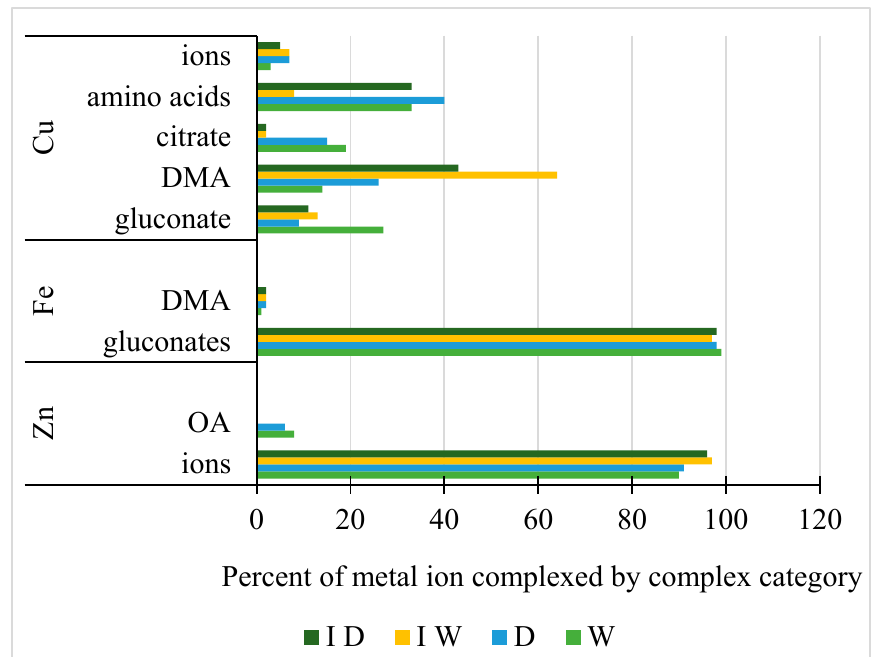
Figure 5. Predicted complexation as % of the total for three essential metals (Cu, Fe, and Zn) when present together in the rhizosphere for four growth conditions: non-inoculated watered (W), non-inoculated (D), inoculated with Pc O6 and watered (I W), and inoculated with Pc O6 with drought-stress (ID). For modeling pH 7.25 was used. Complexation with amino acids, inorganic anions and organic acids (OA) are shown, as well as chelation with the phytosiderophore, DMA, and the presence of free ions. The full data set is provided in Supplementary